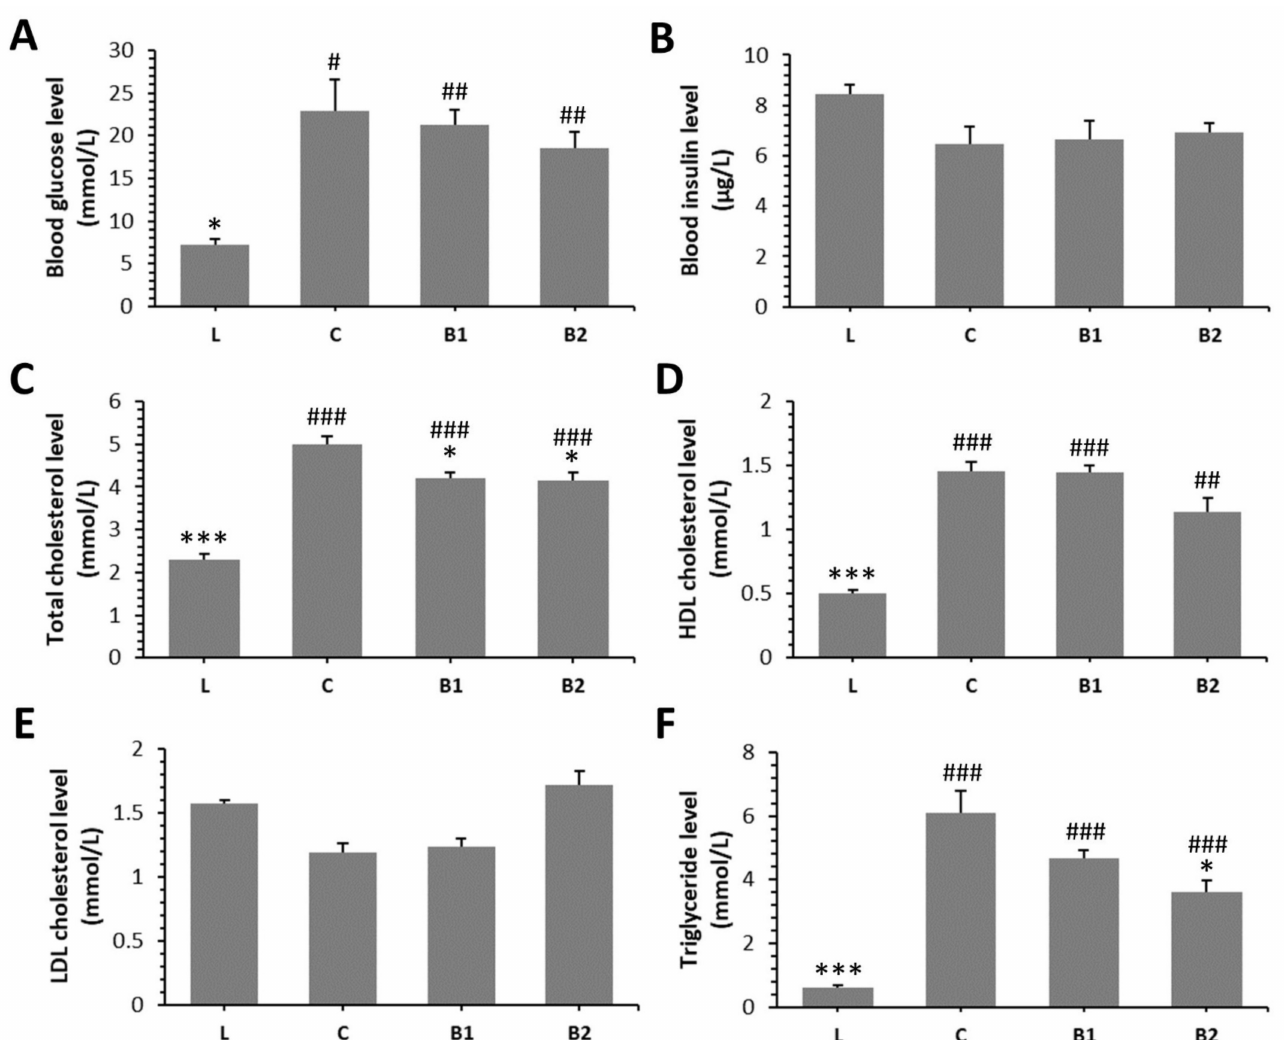
Figure 1. Effects of bee bread (BB) on levels of blood glucose ( A ), blood insulin ( B ), total cholesterol ( C ), high-density lipoprotein (HDL) cholesterol ( D ), low-density lipoprotein (LDL) cholesterol ( E ), triglyceride ( F ) in Zucker diabetic fatty (ZDF) rats. * Significant differences compared with C group ( p < 0.05), *** significant differences compared with the C group ( p < 0.001), # significant changes in relation to the L group ( p < 0.05), ## significant changes in relation to the L group ( p < 0.01), and ### significant changes in relation to the L group ( p <